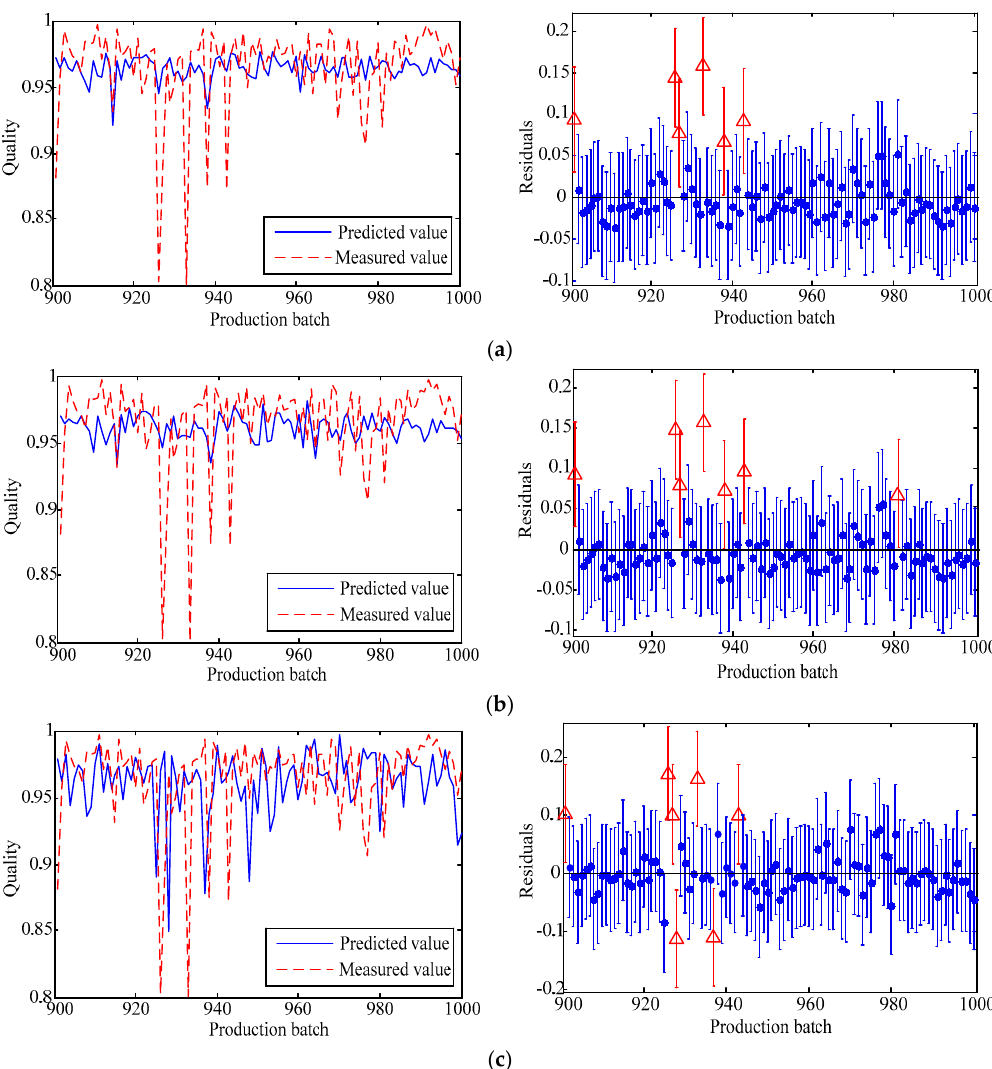
Figure 7. Prediction results of Case 1 using different models. ( a ) AE-based DRN with 19-25-25-1, ( b ) least squares support vector regression (LSSVR), and ( c ) BPNN with 19-10-1.